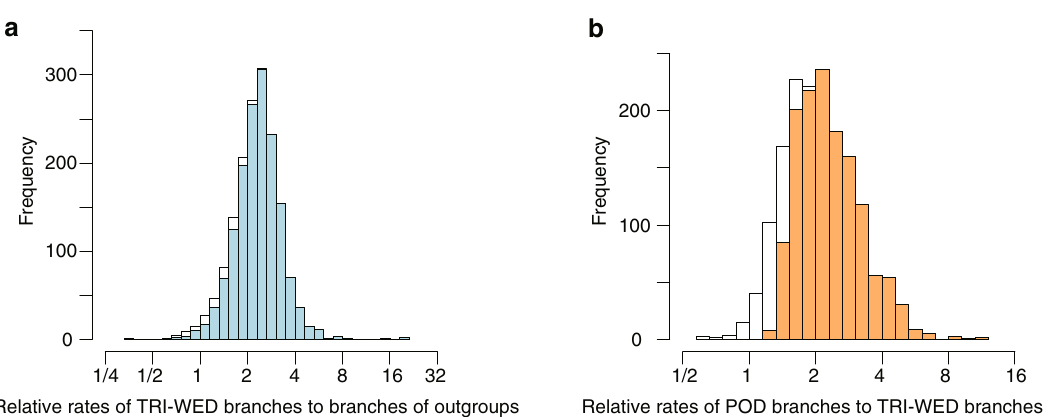
Fig. 3 Distribution of the relative substitution rates of 1640 orthogroups. a Histogram of the relative substitution rates of the branches of basal Tristichoideae and Weddellinoideae compared with the outgroup branches. b Histogram of the relative substitution rates of Podostemoideae branches compared with the branches of basal Tristichoideae and Weddellinoideae. The distribution of the orthogroups, in which relative-rate tests showed signi fi cant results ( q < 0.05), is coloured blue ( a ) and orange ( b ). POD Podostemoideae, TRI Tristichoideae, WED Weddellinoideae.